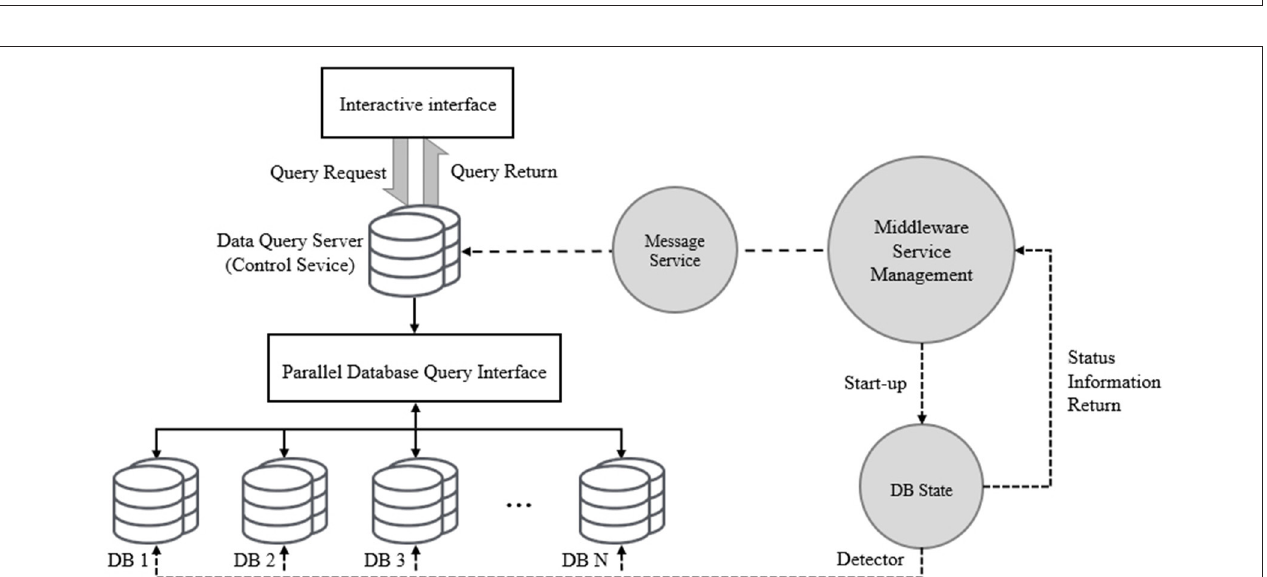
FIGURE 8 | The flow of collaborative